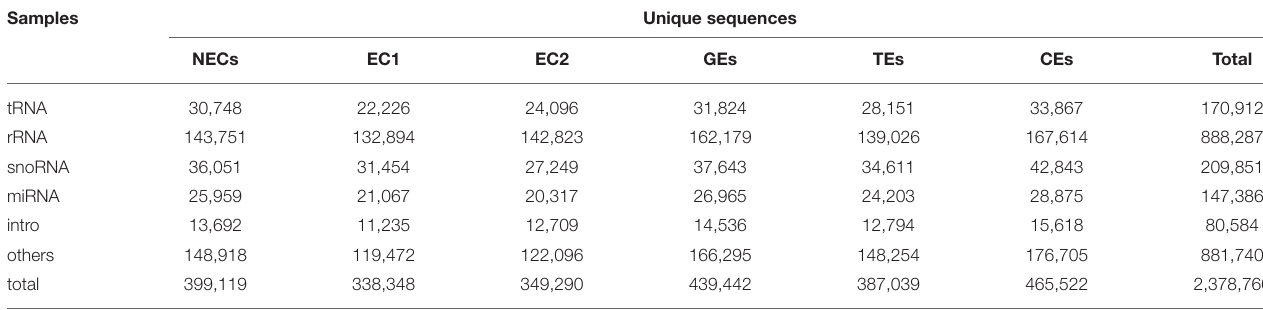
TABLE 1 | Summary of Rfam